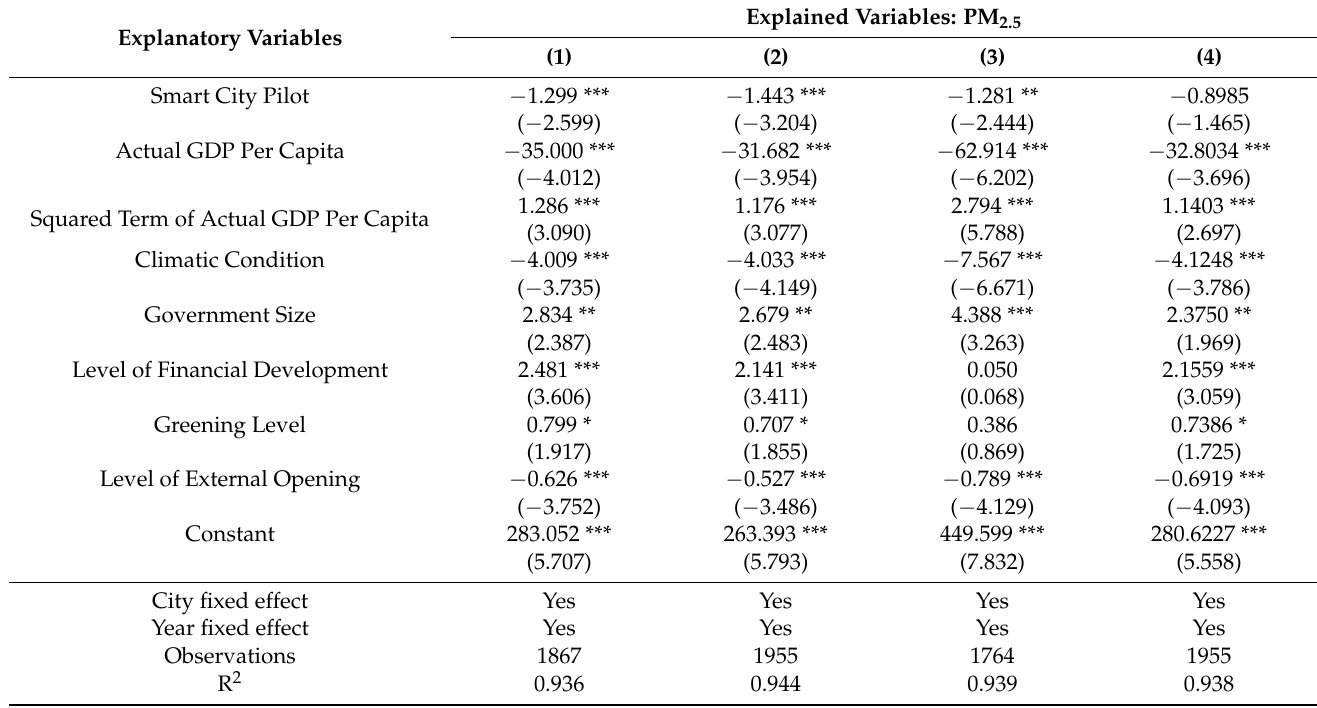
Table 4. Regression results of the robustness